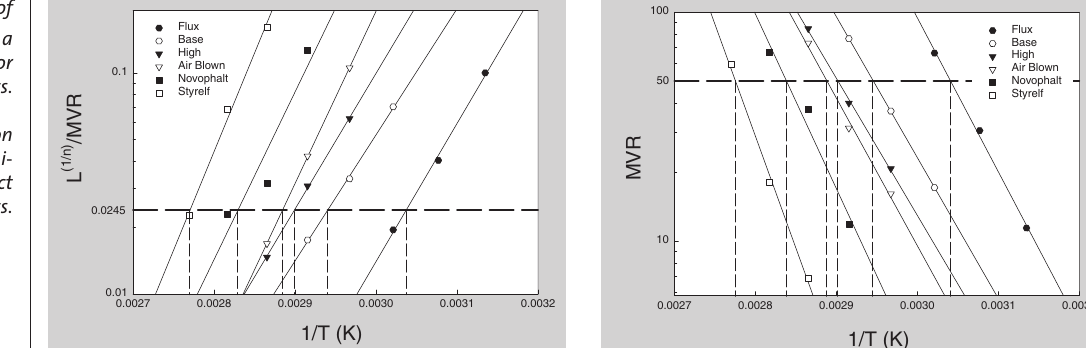
Figure 12 (left): Variation of L1/n/MVR versus 1/T on a semi-logarithmic plot for select asphalts. Figure 13 (right): Variation of MVR versus 1/T on a semi- logarithmic plot for select